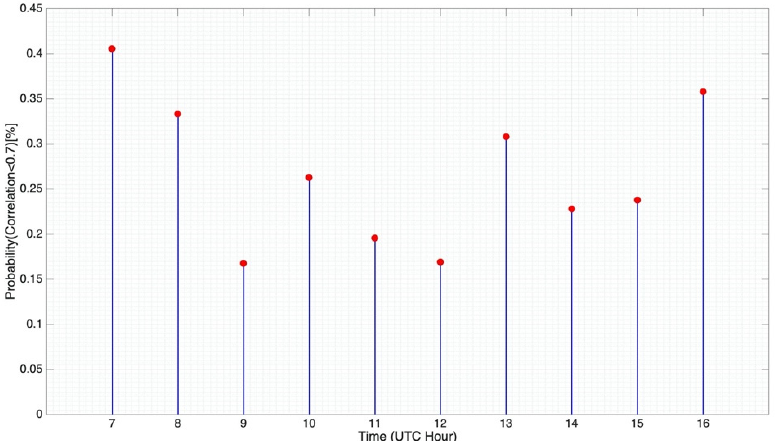
Figure 10. Probability (in %) of finding a cross-correlation coefficient below 0.7 between both channels.